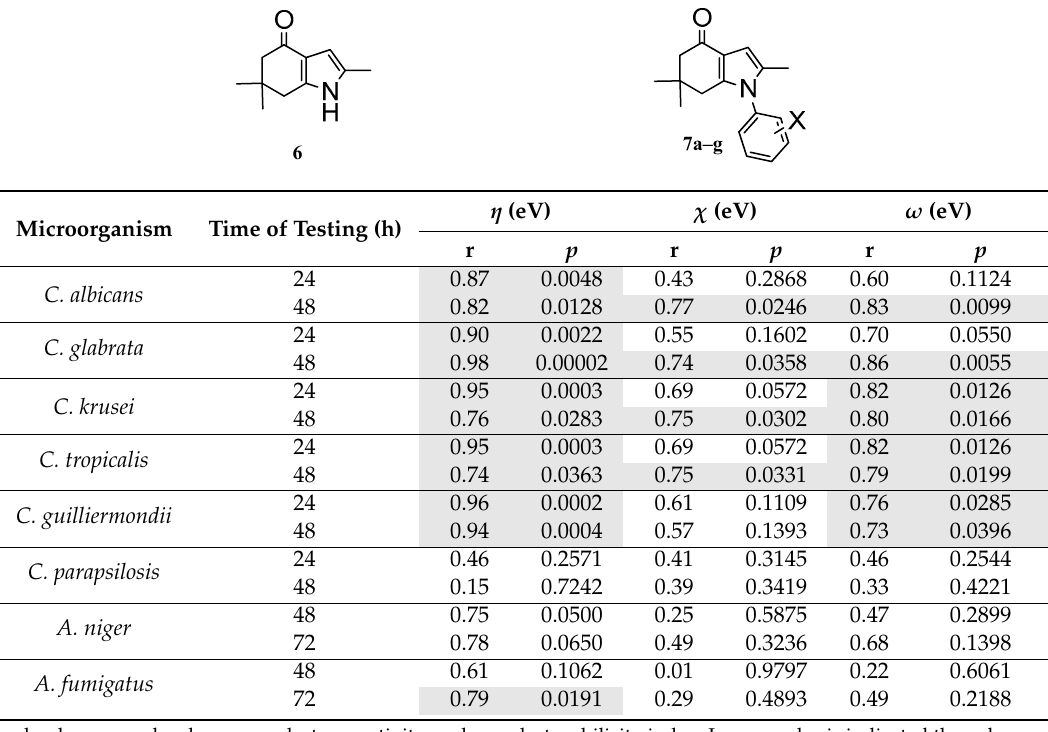
Table 3. Pearson coefficient for each simple lineal regression for series I: Compounds 6 and 7a – g